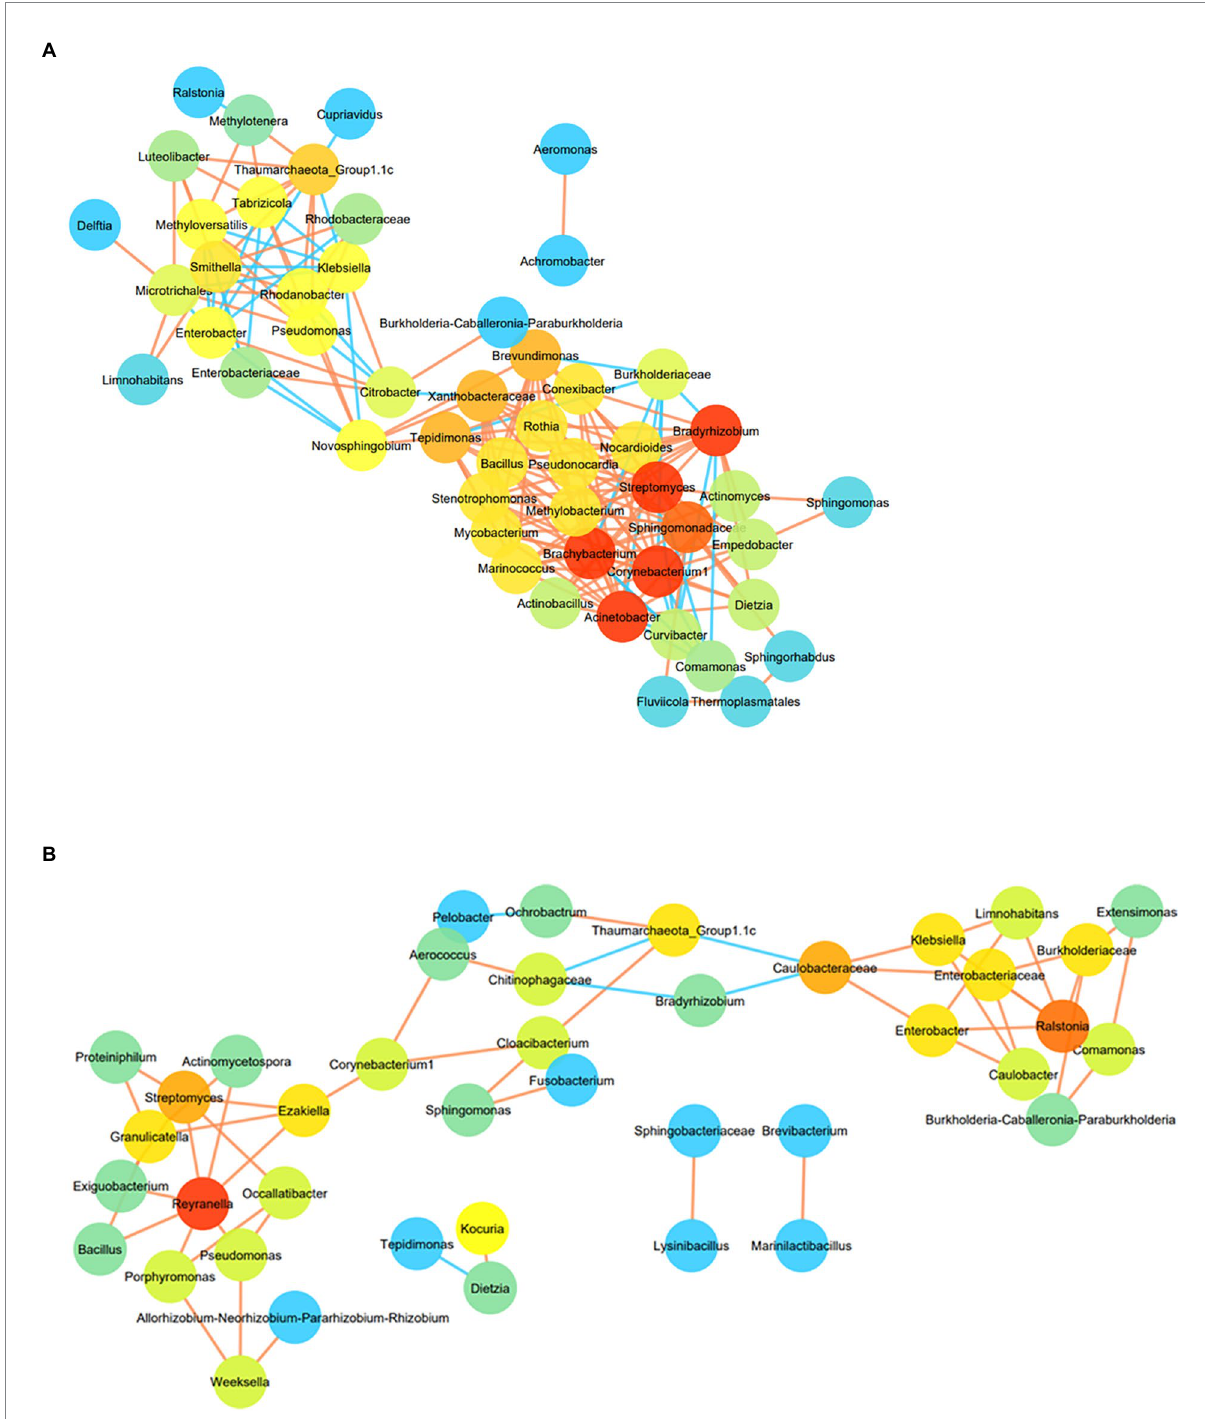
FIGURE 7 (A) Co-occurrence network of OTUs enriched from at least 4 samples (at the lowest taxa level) in HC enrichment. Node colour are proportional to the number of degrees. Nodes with higher degree are orange in colour than those with lower connections (blue in colour). Colour of the edges represents the strength of the Spearman’s correlations between the nodes. Edges with stronger correlation are orange in colour. For the Spearman correlation values | r | > 0.9 are only considered. (B) Co-occurrence network of OTUs enriched from at least 4 samples (at the lowest taxa level) in BC enrichment. Node colour are proportional to the number of degrees. Nodes with higher degree are orange in colour than those with lower connections (blue in colour). Colour of the edges represents the strength of the Spearman’s correlations between the nodes. Edges with stronger correlation are orange in colour. For the Spearman correlation values | r | > 0.9 are only